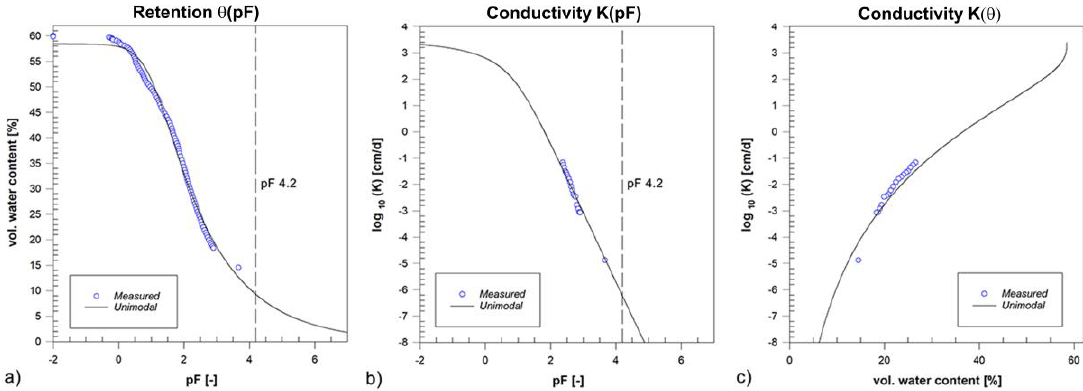
Figure 4. ( a ) The soil water retention curve showing the volumetric water content ( θ ) versus pF (decimal log of tension, expressed as pressure head in the unit of cm); ( b ) the conductivity curves showing the log of the hydraulic conductivity (K) versus pF, and ( c ) the log of hydraulic conductivity versus volumetric water content ( θ ).